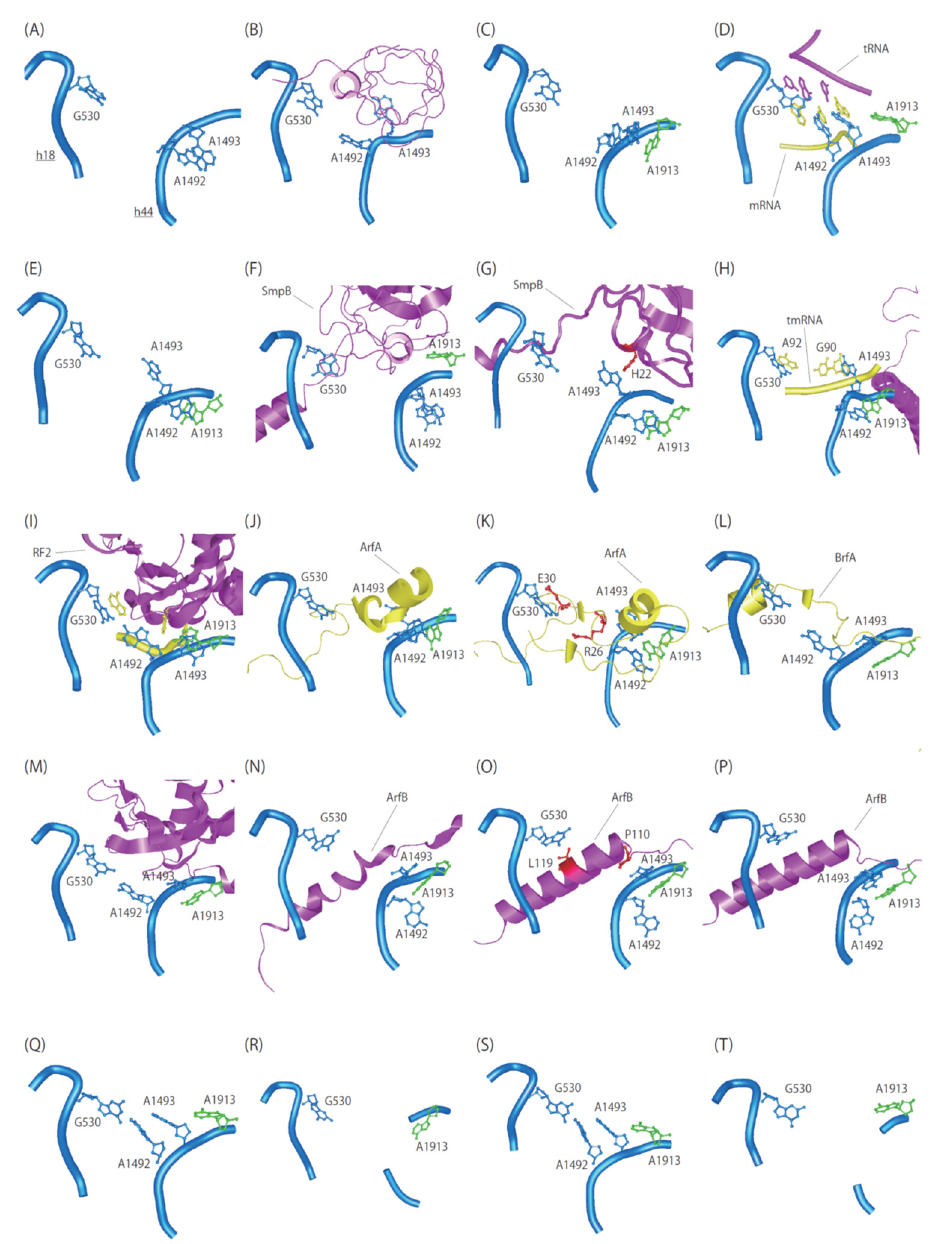
Figure 2. Conformation of rRNA and ribosome rescue factor in the decoding center. 16S and 23S rRNA nucleotides are shown in cyan and green, respectively. ( A ) Vacant A-site of the 30S subunit (PDBID:1J5E). ( B ) IF1 (magenta) bound to the 30S subunit (PDBID:1HR0). ( C ) Vacant A-site of the 70S ribosome (PDBID:4YBB). ( D ) Cognate tRNA (magenta) and mRNA codon (yellow) in the A-site of the 70S ribosome (PDBID:7K00). ( E ) Truncated mRNA bound to the 70S ribosome